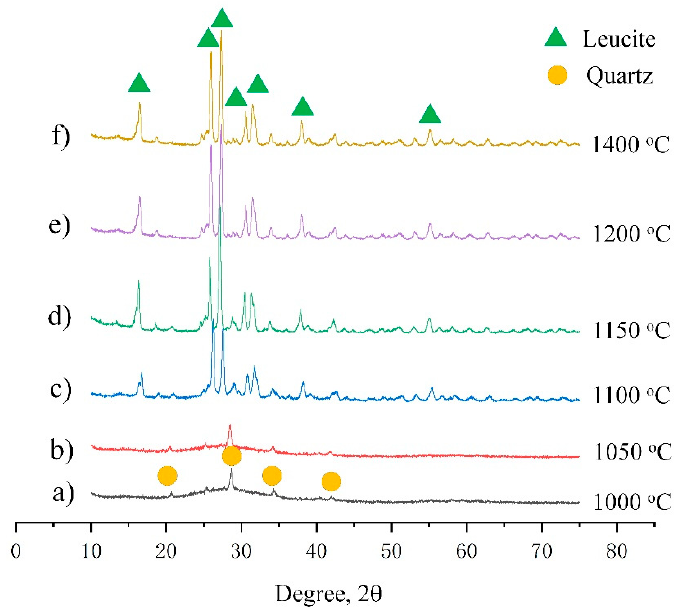
Figure 2. XRD pattern of the geopolymer materials calcined at various temperatures. (a) 1000 °C, (b) 1050 °C, (c) 1100 °C, (d) 1150 °C, (e) 1200 °C, and (f) 1400 °C.